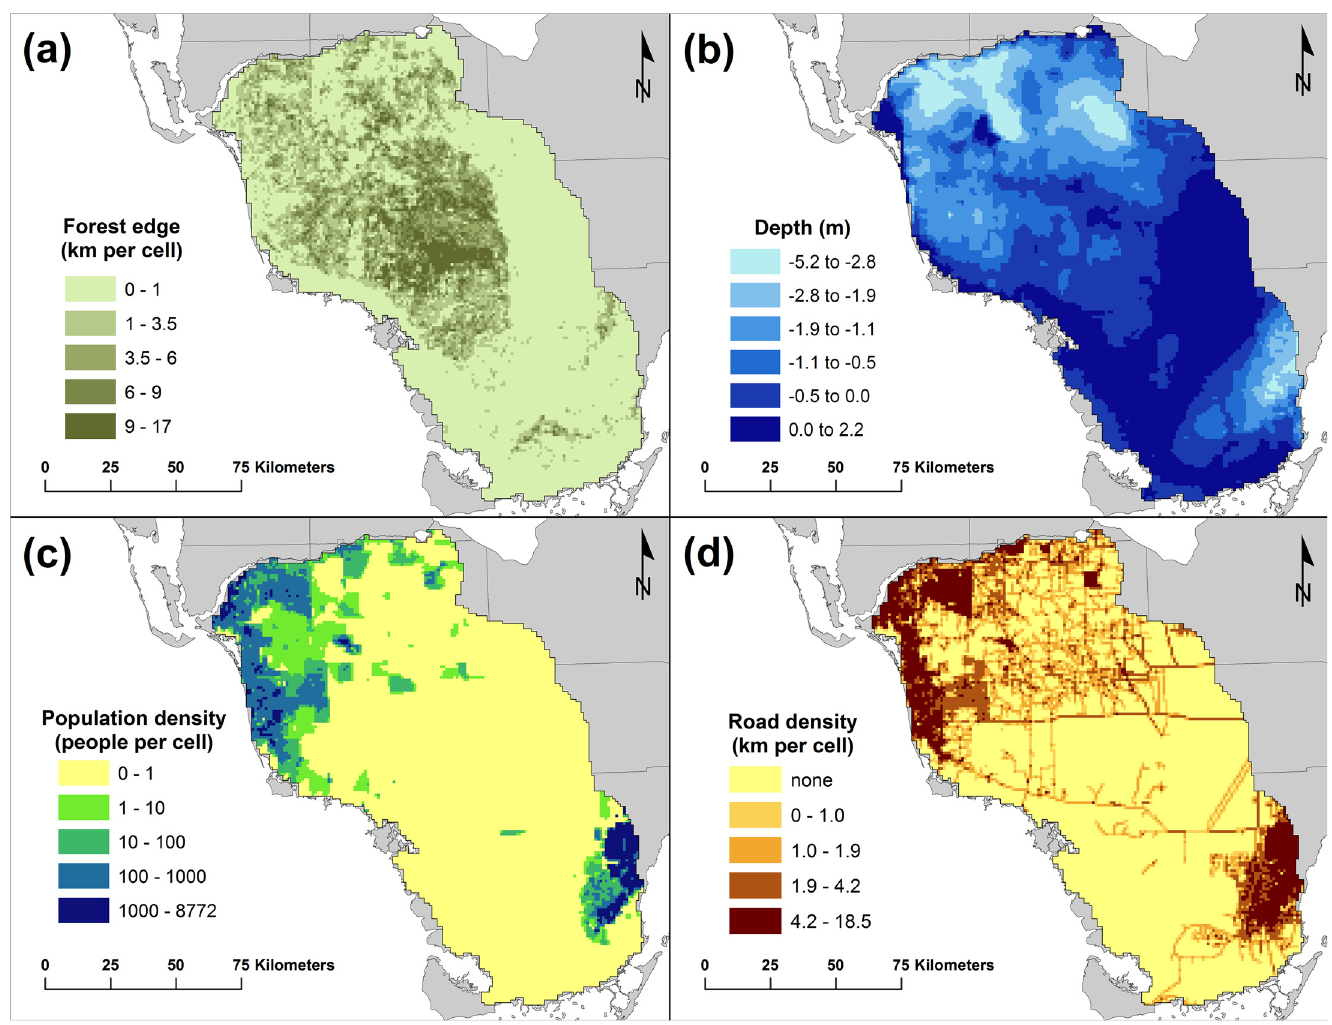
Fig 2. Landscape characteristics within the study area used as explanatory variables. (a) amount of forest edge (km/km 2 ); (b) average water depths during the dry season (m); (c) area-weighted average human population density (people/km 2 ); (d) road density (km/km 2